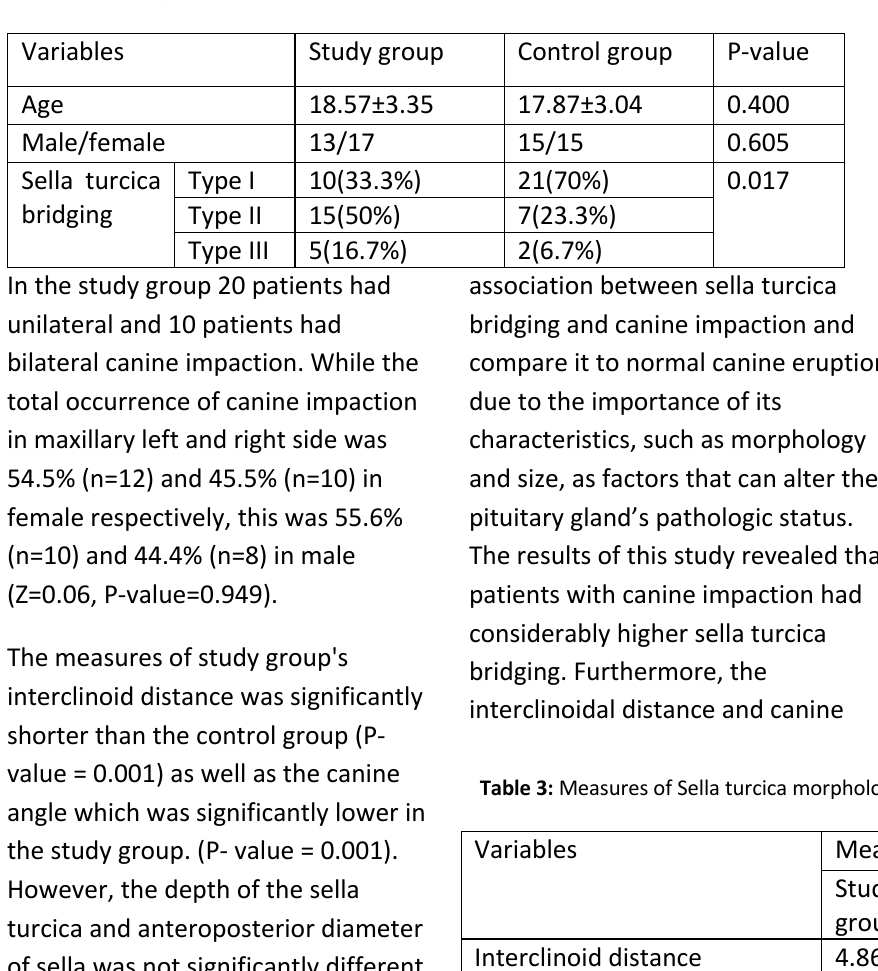
Table 1: Demographic and types of sella turcica bridging in the two groups